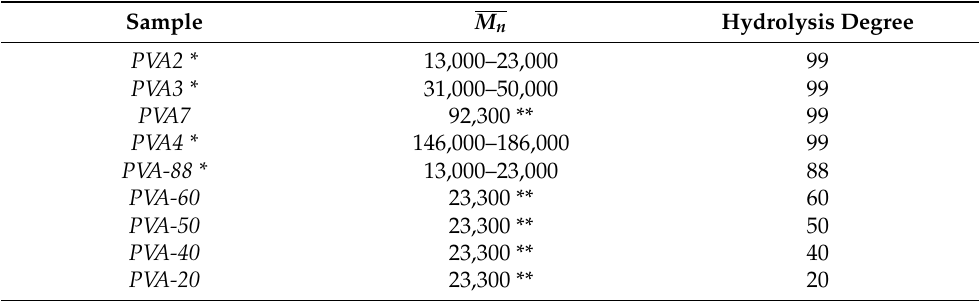
Table 2. Molecular characteristics of polyvinyl alcohol (PVA) used as polymeric stabilizers. * indicates a commercial product, ** indicates the molecular weight of starting material.